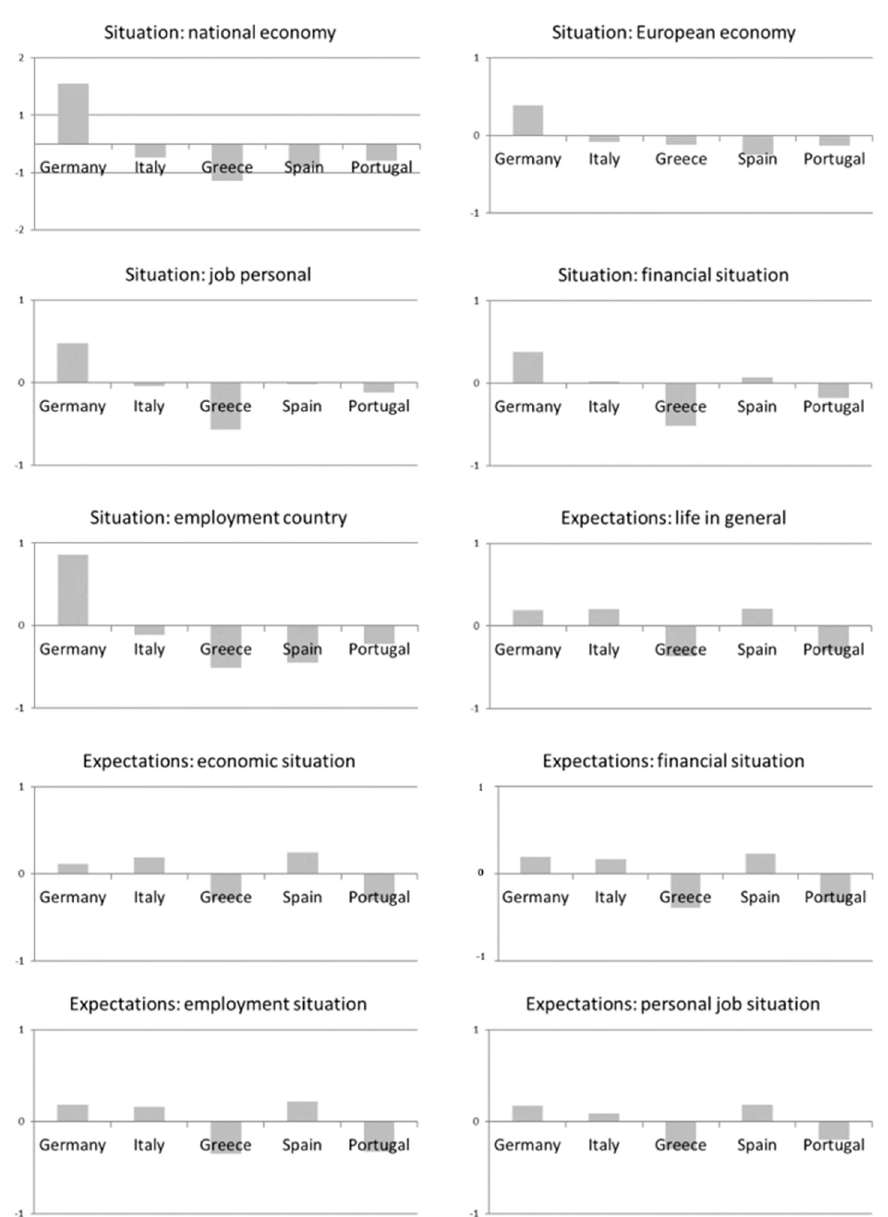
Figure 6. Differences among citizen evaluations and expectations regarding economic indicators in Germany, Spain, Italy, Greece, and Portugal in 2012 (mean evaluation in each country minus aver- age evaluation for our five cases). Source is authors’ own elaboration from Eurobarometer 77.3.